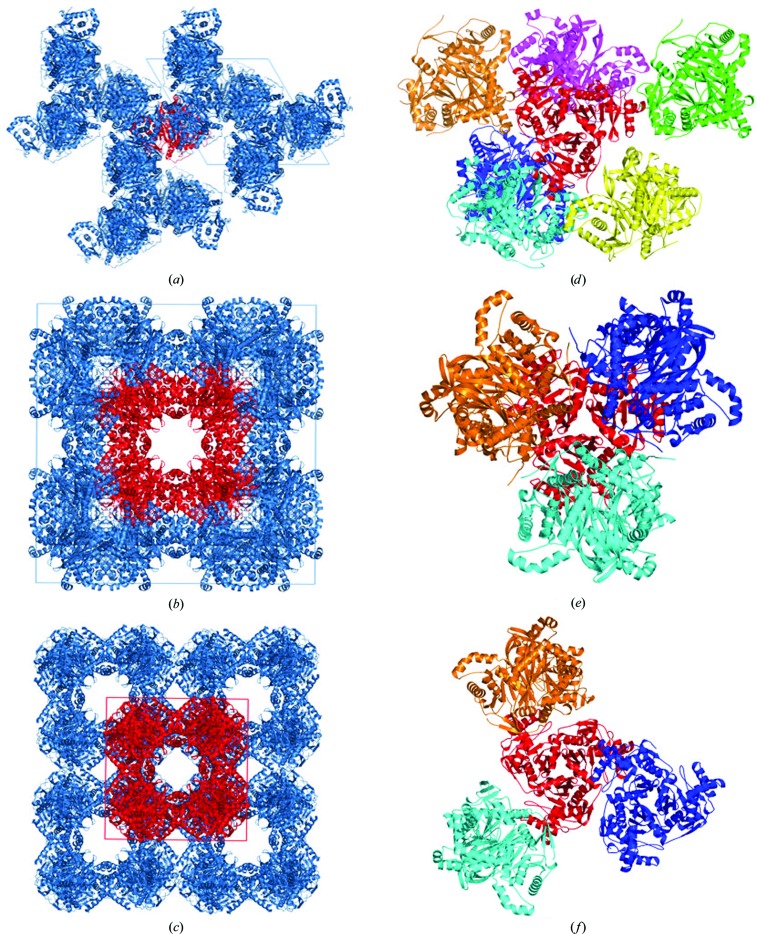
Molecular packing of EcDSCD in three different crystal forms. (a) In space group P3121 (PDB entry 1c4t), the trimer (in red) cannot form the 24-mer biological assembly. The dimensions of the unit cell (blue lines) shown in the plane are a = b = 112.18 Å. (b) In space group F432 (PDB entry 1scz), the packing forms a 24-mer biological assembly (in red). The dimensions of the unit cell (blue lines) shown in the plane are a = b = 220.58 Å. (c) In space group I4 (PDB entry 6pbr, this work), the packing shows a 24-mer biological assembly (in red). The dimensions of the unit cell (red lines) shown in the plane are a = b = 128.60 Å. The building block for all of the crystal forms of EcDSCD is a trimer [shown in red in the P3121 (d), F432 (e) and I4 (f) crystal forms]. Intermolecular interactions between the trimers are unique in the different crystal forms, as shown, while the monomer/trimer itself shows a minimal conformational change between crystal forms [Figs. 3 ▸(b) and 3 ▸(c)]. One trimer (in red) is depicted in the same orientation in all three structures for an easier comparative view.